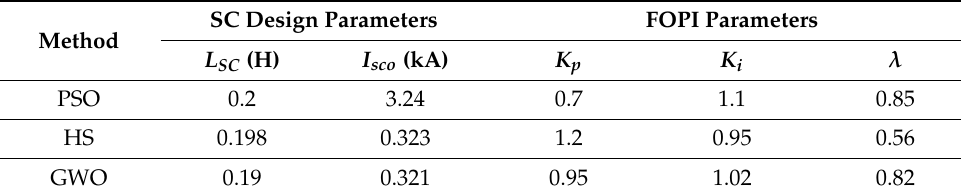
Figure 5. Convergence of PSO, HS and GWO optimization techniques. Table 1. SC rating and parameters of FOPI controller using 3 optimization methods.